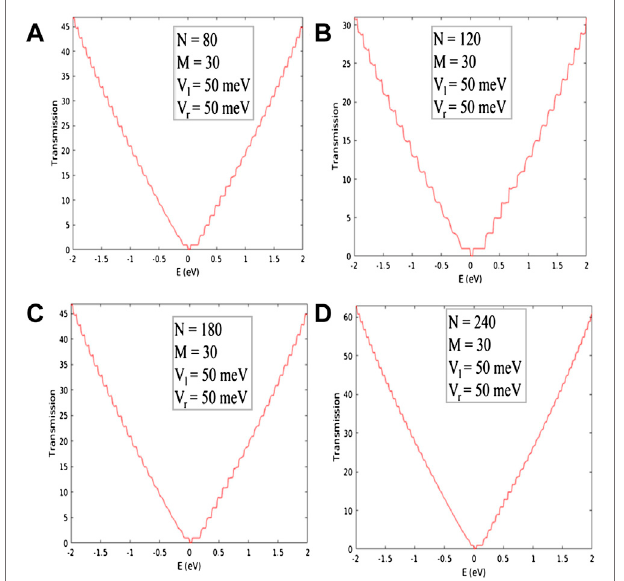
FIGURE 9 | Transmission for asymmetric potential well with (A) N = 80, (B) N = 120, (C) N = 180, and (D) N = 240.